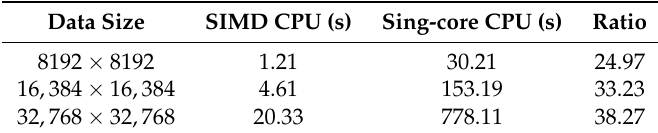
Table 4. Running time of multi-core vector extension CPU based method.